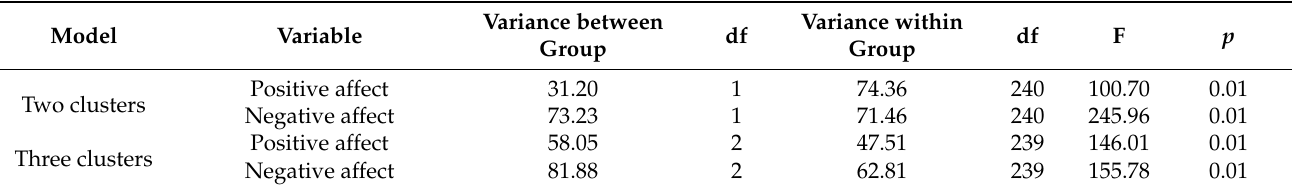
Table 3. Variance within and between groups for PANAS scale: results of k-means cluster